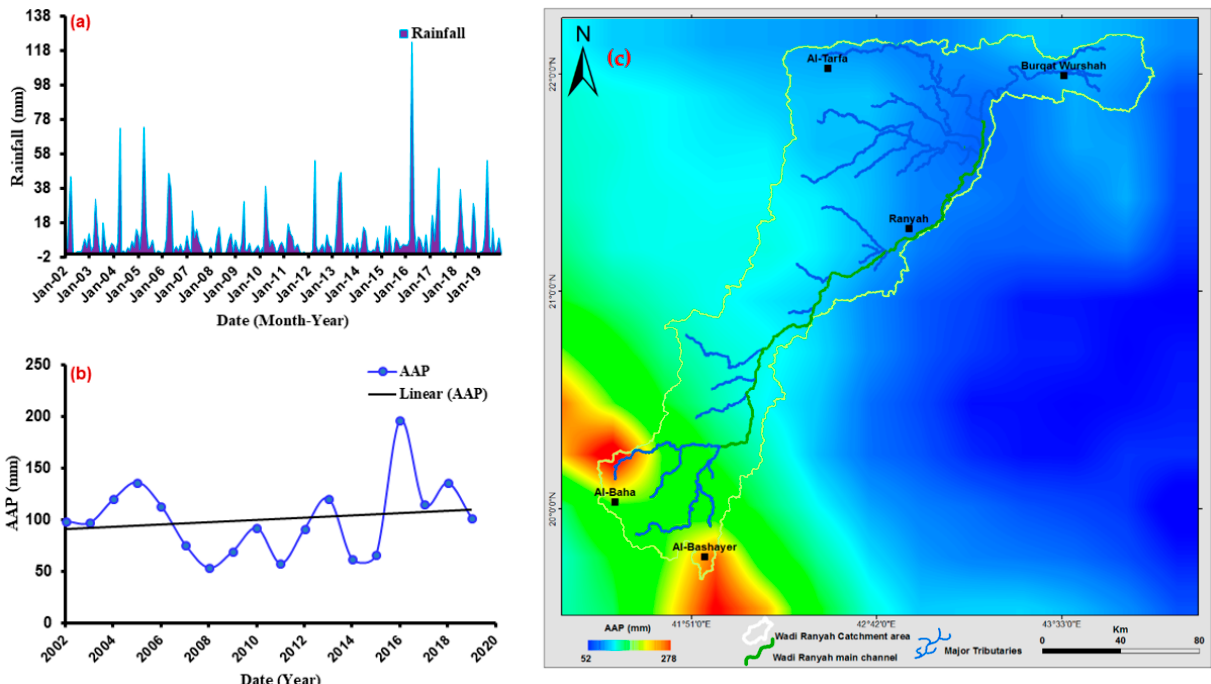
Figure 5. ( a ) Monthly average rainfall (mm), ( b ) the AAP times series, and ( c ) the AAP calculated using TRMM data for the study region.